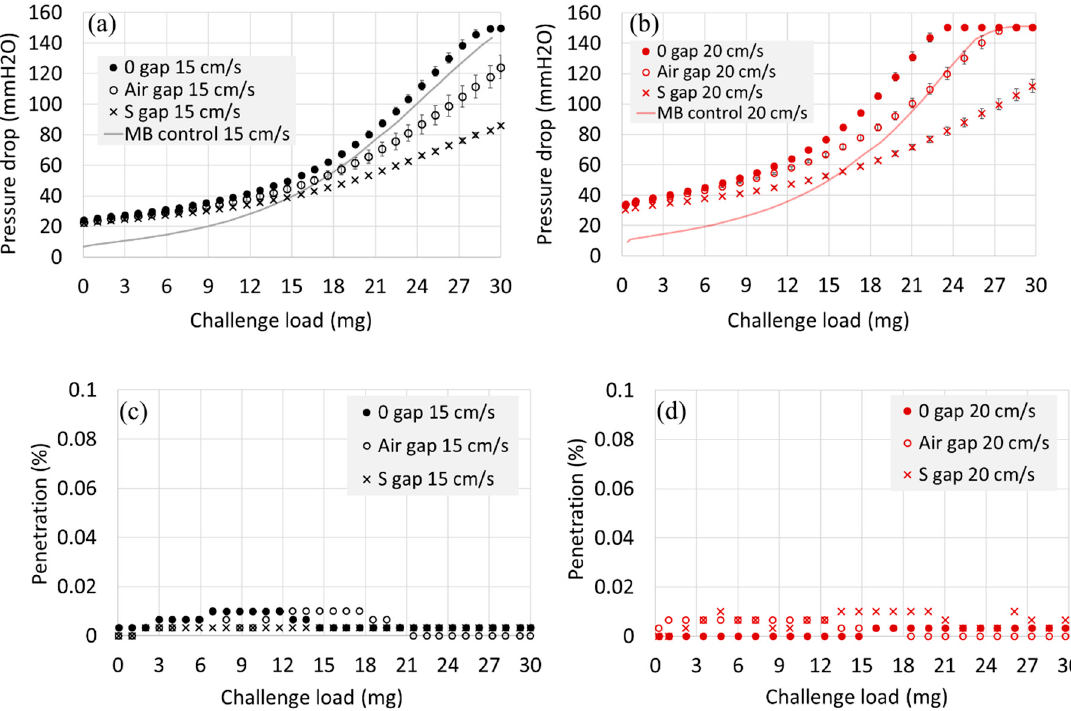
Figure 5. Pressure drop and penetration development for 4-layer constructions during 30 mg of NaCl loading. ( a ) Pressure drop for 15 cm/s, ( b ) Pressure drop for 20 cm/s, ( c ) Penetration for 15 cm/s, ( d ) Penetration for 20 cm/s. Note. For a single layer of spacer web, Pn (%) remained >99.5% and dP (mm H 2 O) remained <0.5 mm H 2 O throughout the loading.